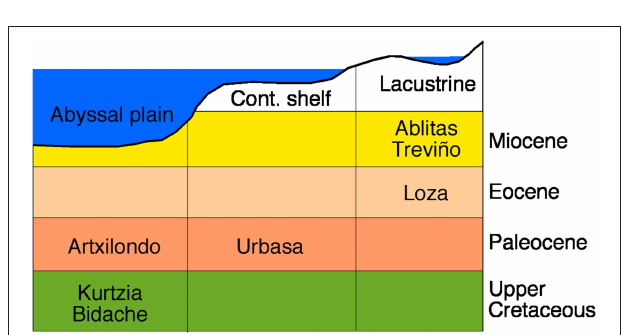
FIGURE 2 | Sketch showing the depositional environment for the studied chert